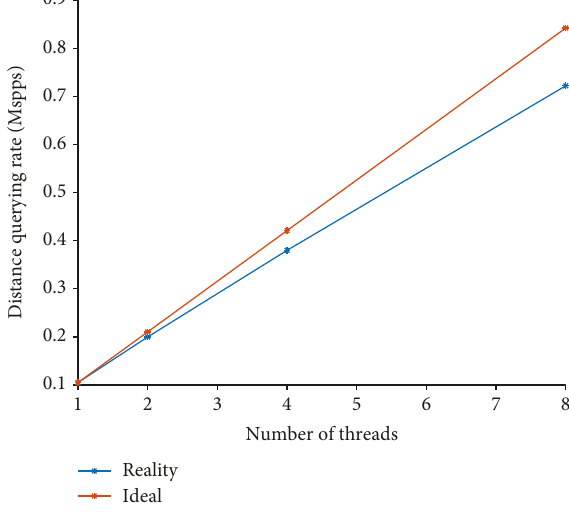
Figure 16: Parallel distance querying pro fi ling